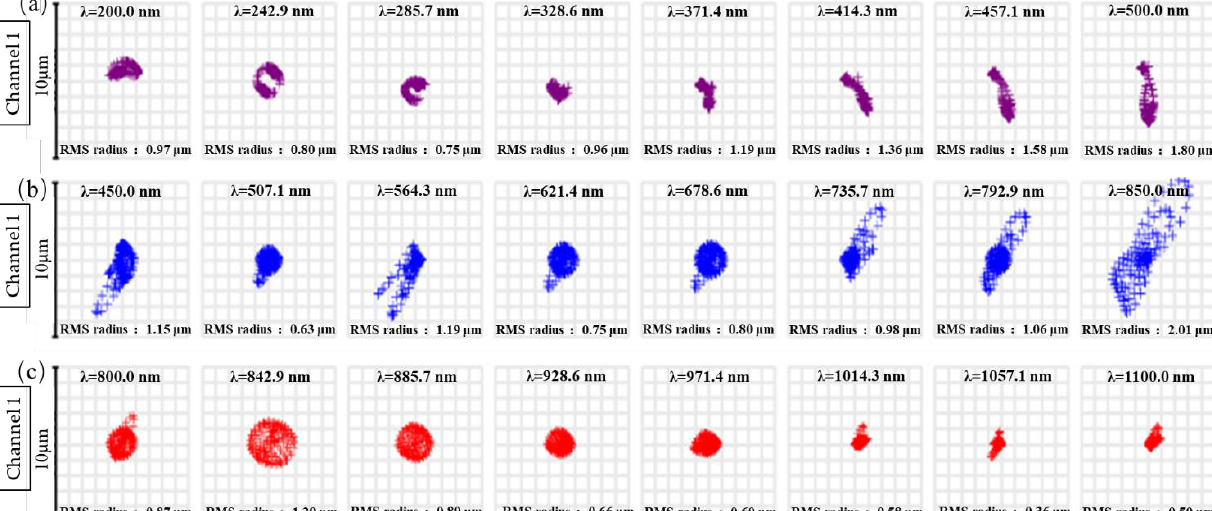
Figure 8. Spot diagrams of eight wavelength points on ( a ) channel 1, ( b ) channel 2, and ( c ) channel 3.